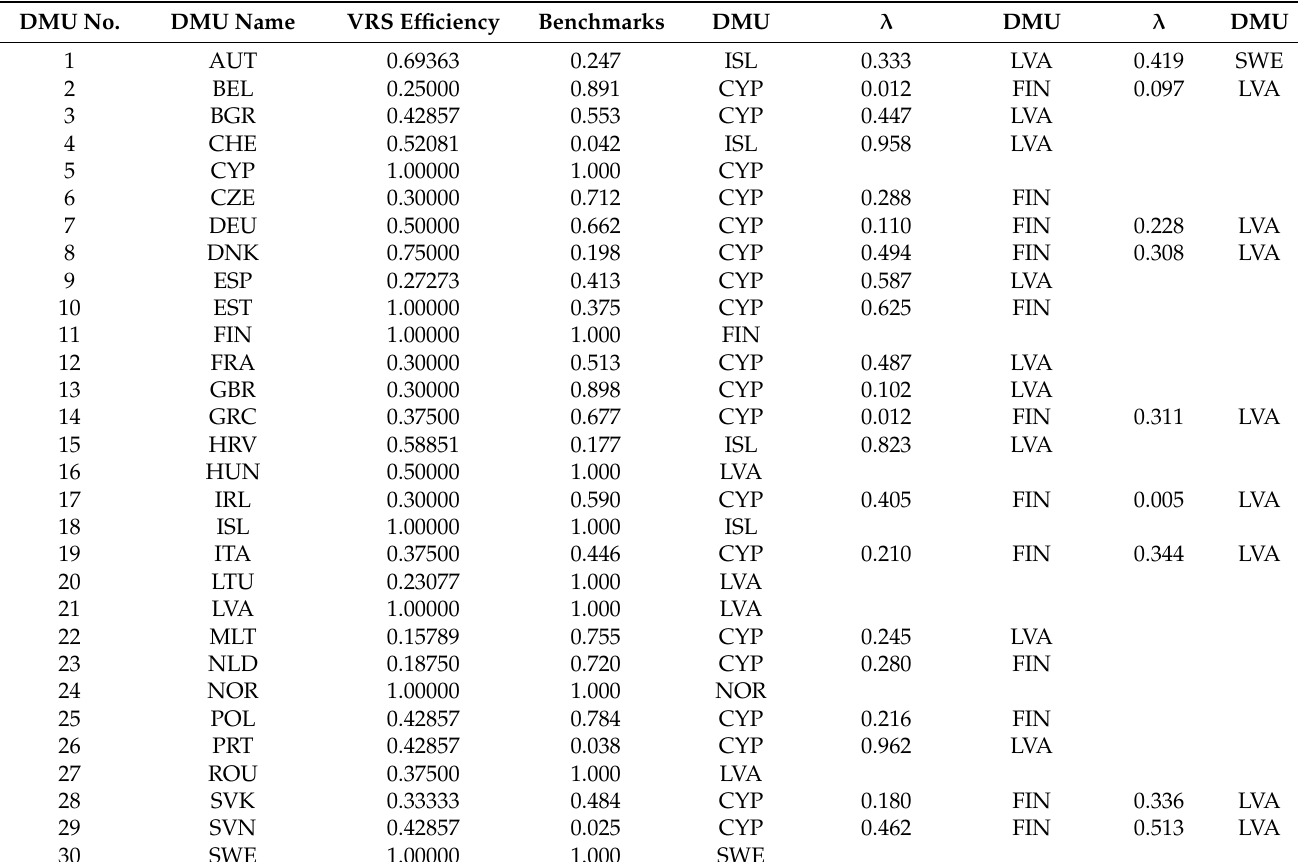
Table A10. Input-Oriented VRS Efficiency of EPS in 2010. Source: Authors’ calculations in DEAFrontier. DMU